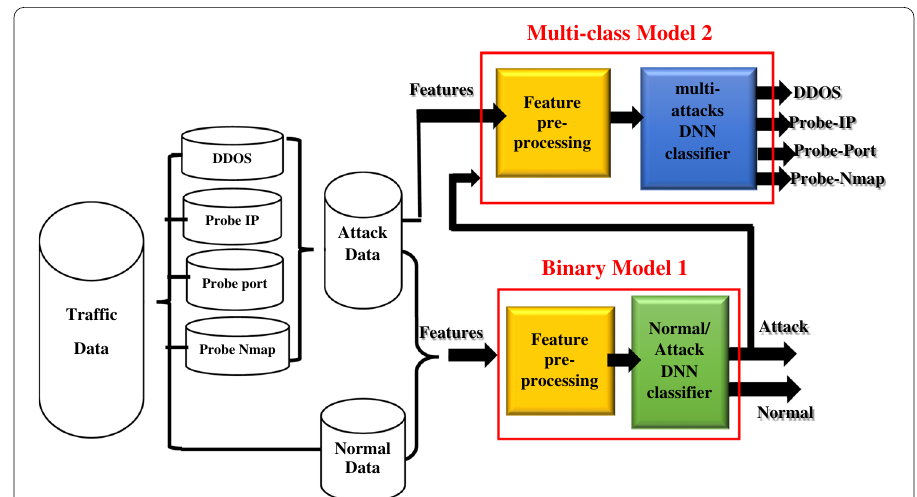
Fig. 5 Block diagram of the proposed model